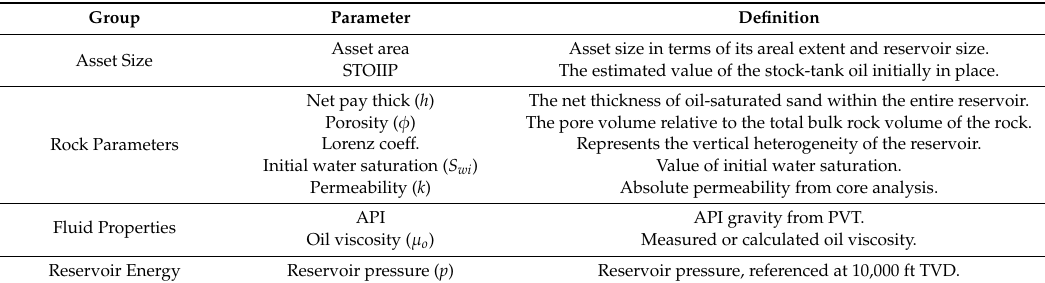
Table 1. The parameters used to generate the artificial intelligence (AI) models. API: American Petroleum